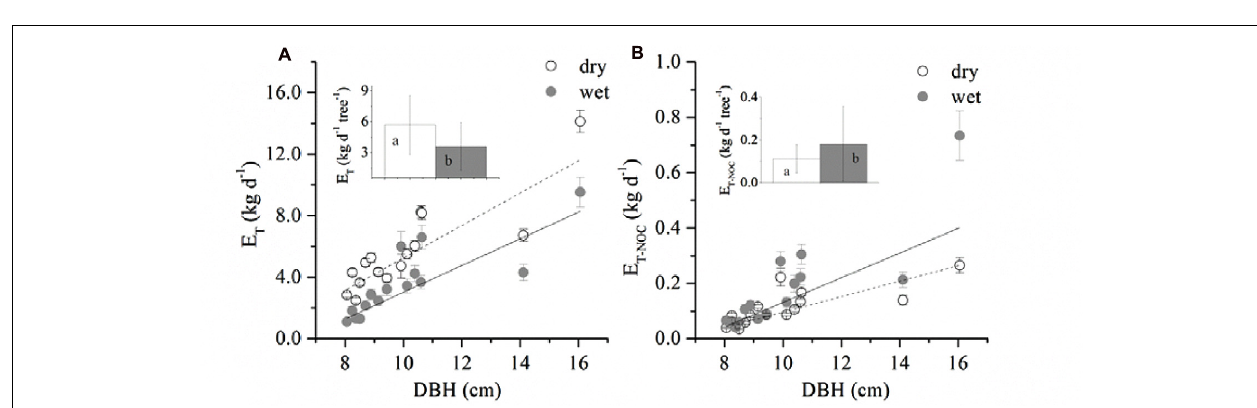
FIGURE 1 | Precipitation (P), soil water content (SWC) and evaporative demand (D) during the period of sap flow measurement. SWC data shown in the figure are daily mean ± SE of that month, n = 28–31.